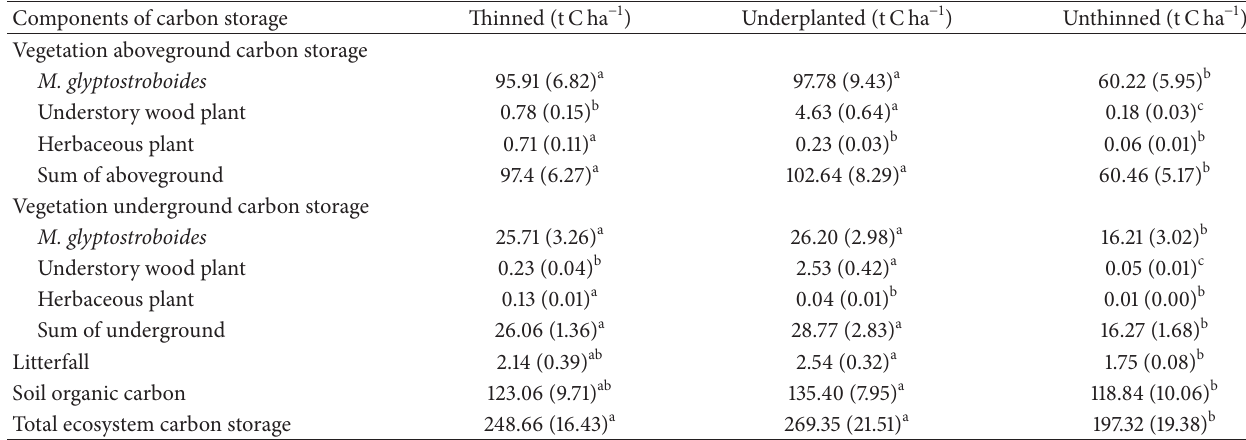
Table 2: Carbon storage in the thinned, underplanted, and unthinned treatments (standard deviation in brackets); different letters in the same line indicate there are significant differences among the three treatments (5% level, Duncan test).